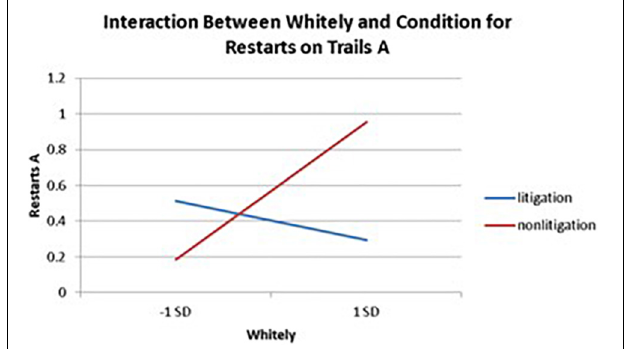
FIGURE 4 | Plotting the interaction between Whitely and condition when predicting restarts on Trails A of the TMT.